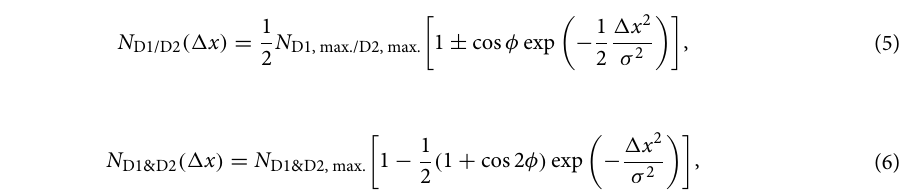
0.01 . ( b ) Ratio of P ( n ) to P ( n n � � =